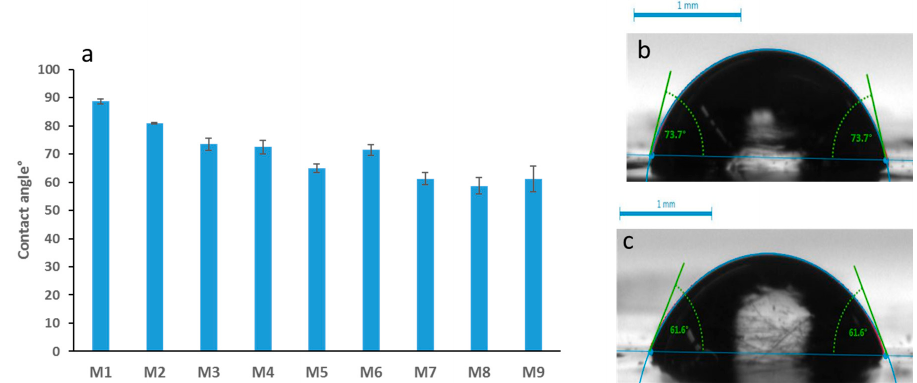
Figure 6. Average contact angle values for synthesized membranes ( a ), sample photographs of contact angles for M4 ( b ) and M7 ( c